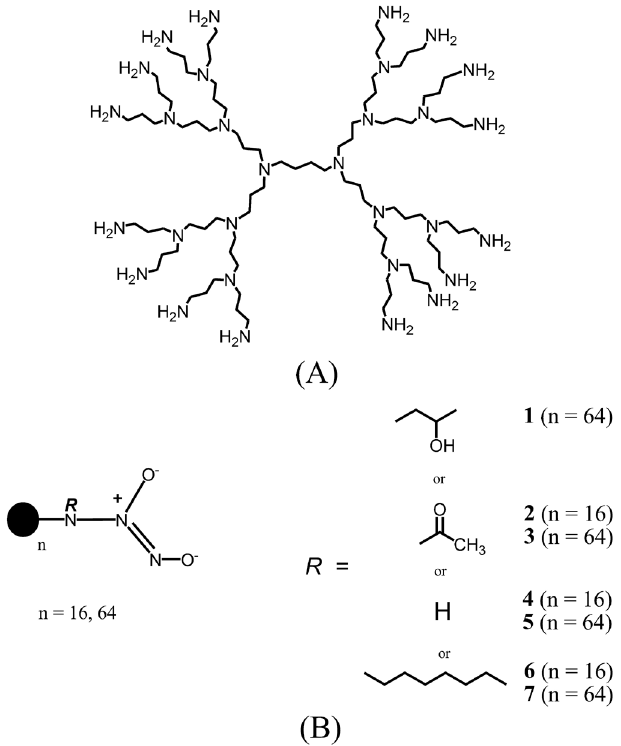
FIGURE 3 - Structure of (A) PPI dendrimer generation 3 and (B) PPI diazeniumdiolates (adapted from Stasko, Schoenfisch,